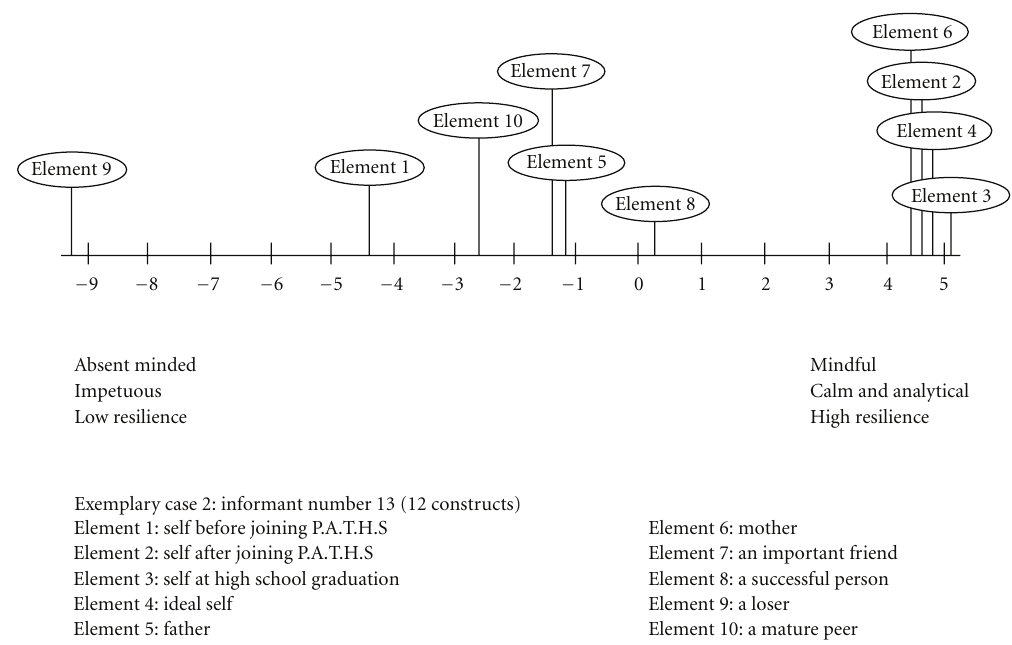
Figure 2: Line graph showing the mental representation of di ff erent roles for case number